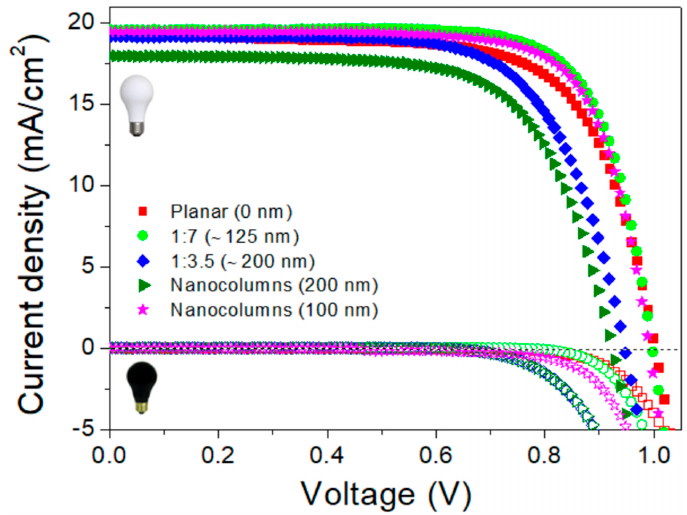
Figure 2. Current density-voltage ( J-V ) characteristics of the best performing PSCs measured in dark and under illumination at AM 1.5G, 100 mW/cm 2 in reverse bias scans performed at 100 mV s − 1 , for different electron selecting layers. Hollow symbols indicate the dark current of the different ESL-based